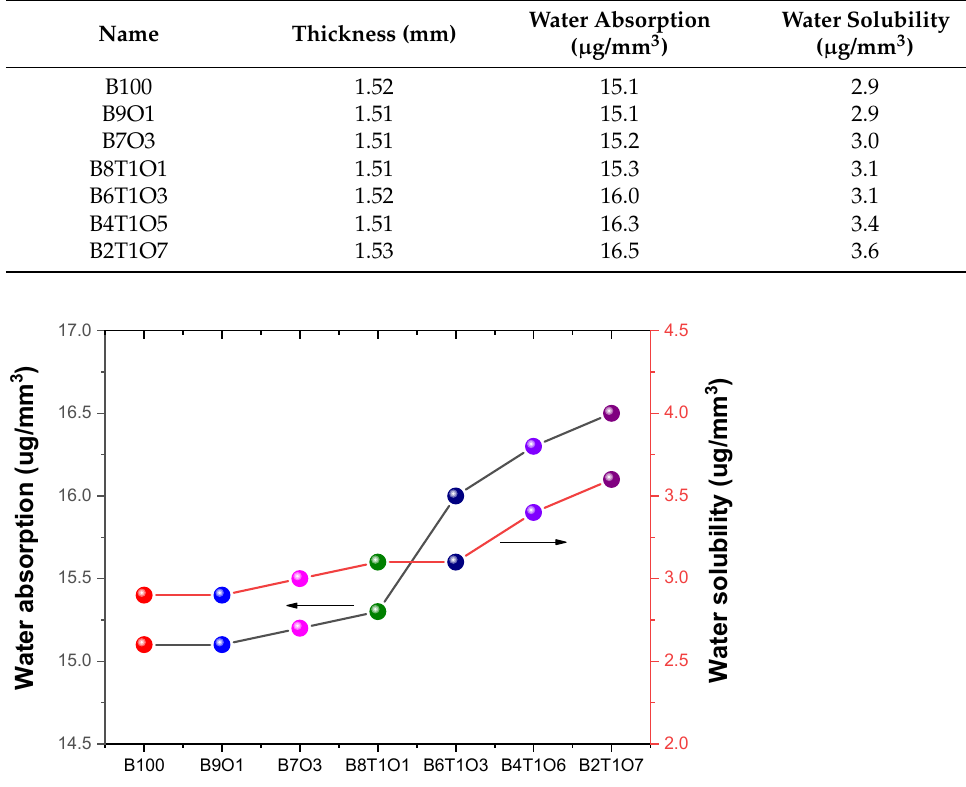
Table 4. Water absorption and solubility of the urethane acrylate resin materials.